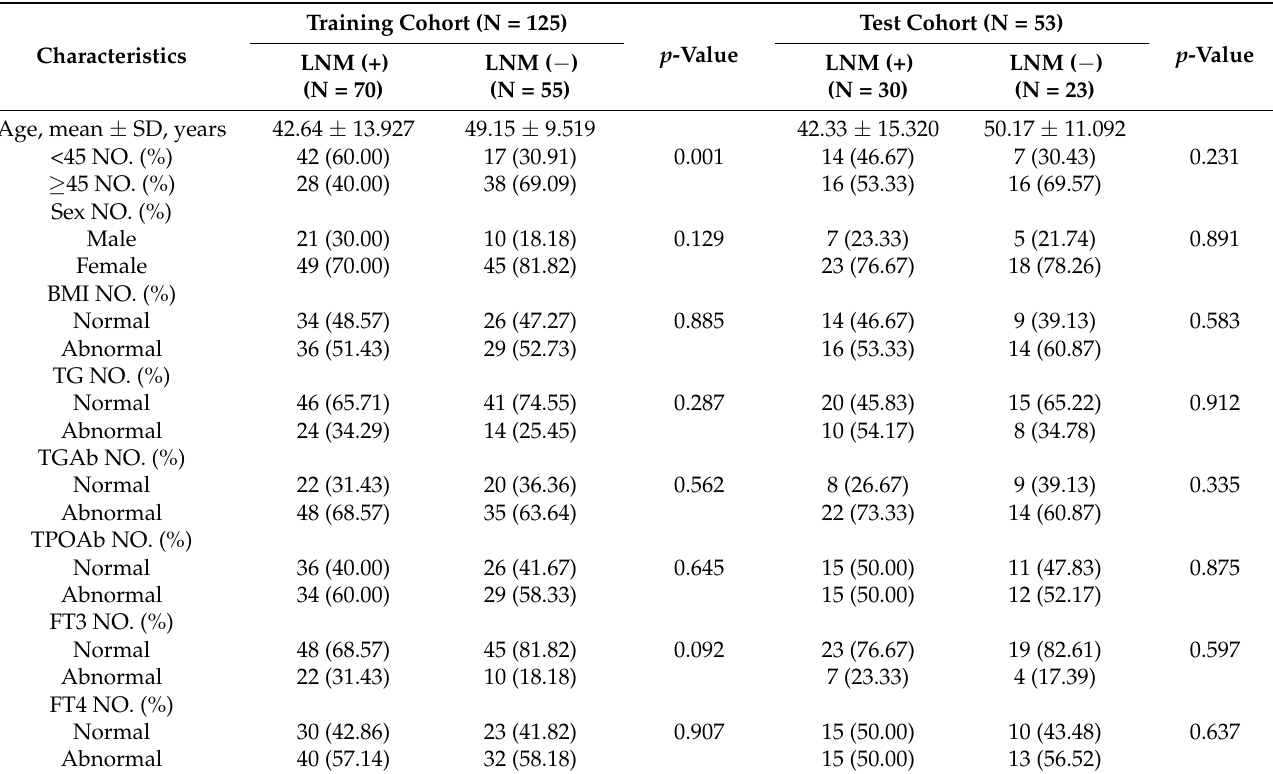
Table 2. Clinical characteristics of the patients in the training and test